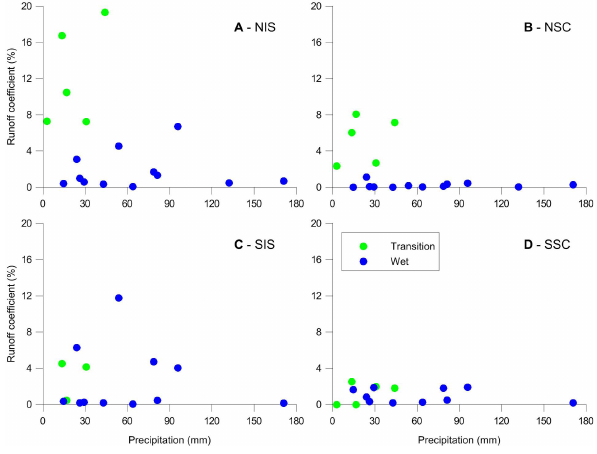
Fig. 5. Relation between runoff coefficient and precipitation. NIS: north-facing inter-shrub; NSC: north-facing shrub-covered; SIS: south-facing inter-shrub; SSC: south-facing shrub-covered.